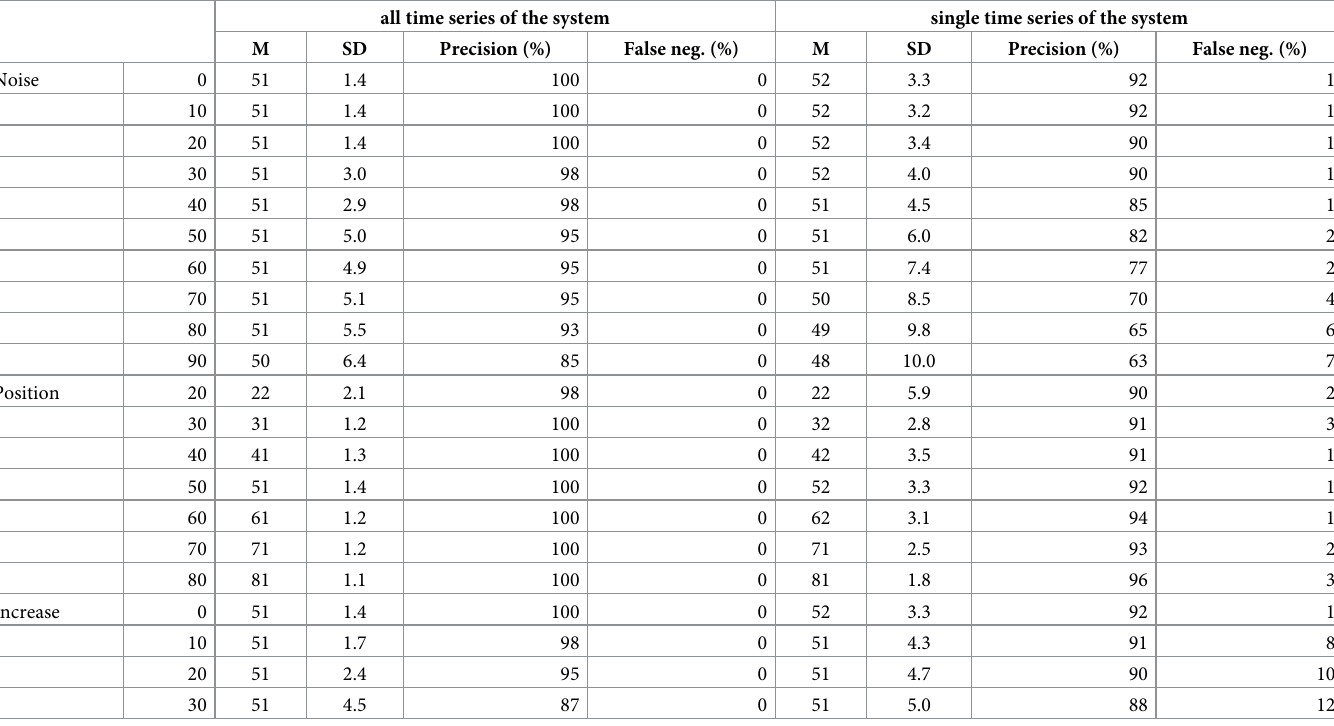
Table 2. Results of the performance of the PTDA under three real-world conditions. Noise : different levels of noise were added to the original time series. The numbers in the second column denote the strength of noise, e.g., 50 refers to added noise with a variance of 50% of the original time series. Position: The transition point was shifted along the time series. The numbers in the second column denote where the change was induced, e.g., 50 refers to a transition point at 50% (the middle) of the original time series. Increase: The transition was not induced abruptly but over a longer period of time. The numbers in the second column denote the range of the time series where the change occurred, e.g., 20 denotes that the change stretched over 20% of the time series (see also Fig